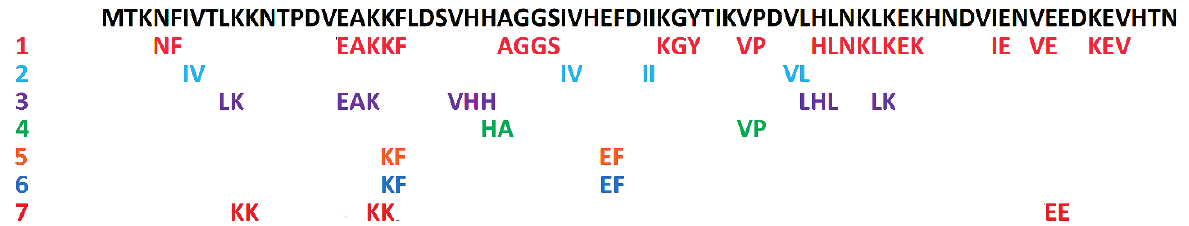
Figure 1. Location of biologically active fragments in the sequence of yeast ( Saccharomyces cerevisiae , strain ATCC 204508/S288c) protease B inhibitor 2 (Accession No P0CT04 in the UniProt Knowledgebase [21,22]). (1) angiotensin I-converting enzyme (ACE) inhibitors; (2) glucose uptake stimulators; (3) antioxidant fragments; (4) dipeptidyl peptidase IV inhibitors; (5) calmodulin-dependent phosphodiesterase 1 inhibitors; (6) renin inhibitors; (7) fragments with other activities (see Table 1). Bioactive fragments were found with the use of the BIOPEP search engine [23,24] where the protein sequence was the query. The search was performed in May